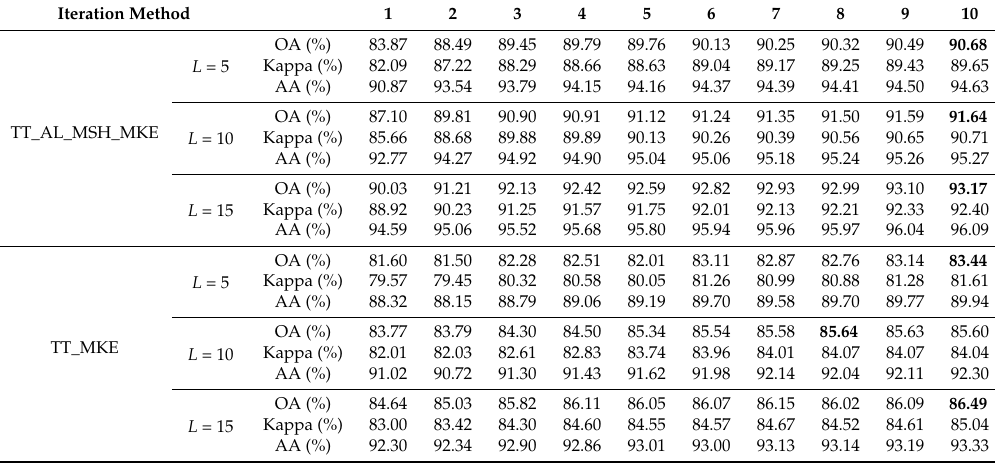
Table 7. Overall accuracy using two different techniques for AVIRIS Salinas Valley data, with 5, 10 and 15 initial training samples per class. The best OA results of each table are marked in bold italics. Iteration